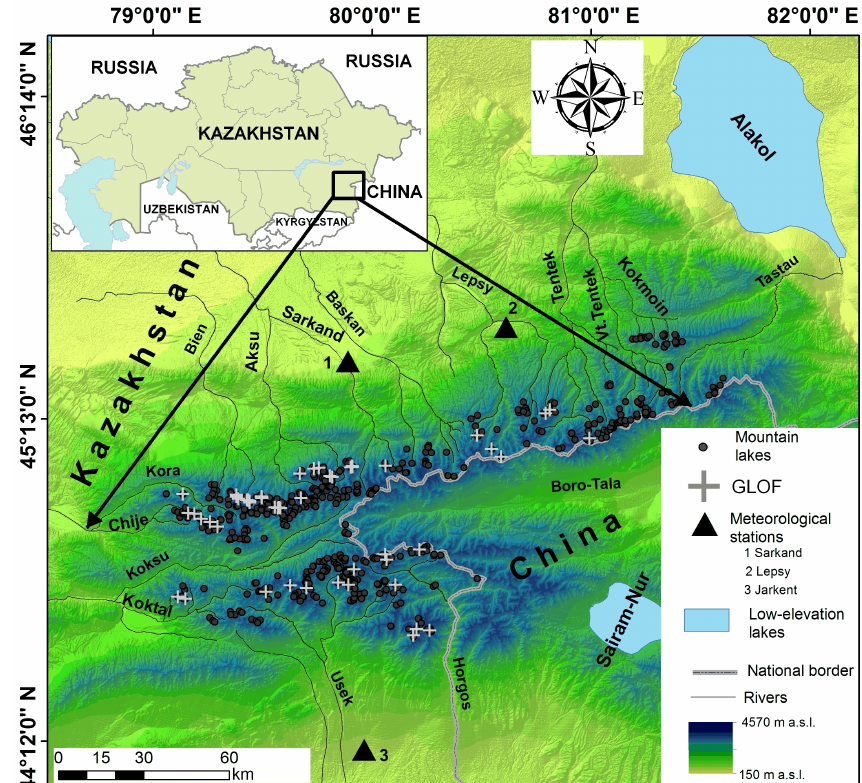
Figure 1. Study area. GLOF symbols show lakes identified as potentially in danger of outburst. Meteorological stations: 1 – Sarkand (764m a.s.l); 2 – Lepsy (1012ma.s.l.); 3 – Jarkent (643ma.s.l.).